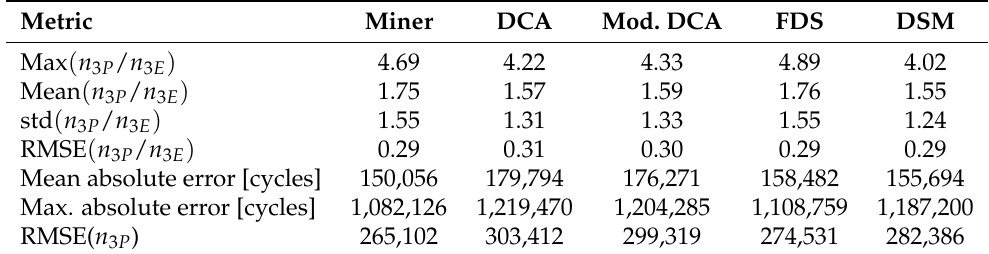
Table 5. Statistical analysis of the selected damage accumulation model predictions based on the newly generated three-level block loading dataset.